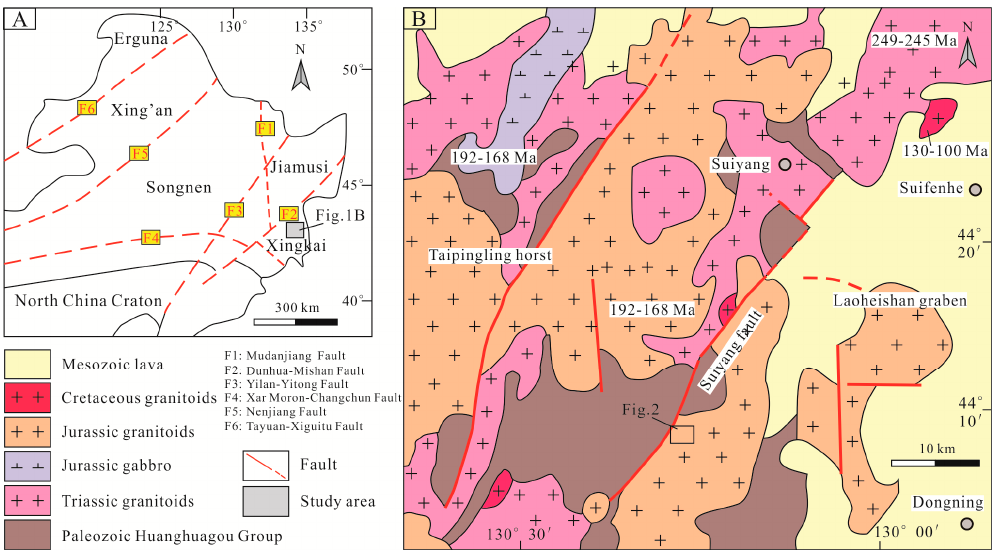
Figure 1. ( A ) Simplified tectonic map of northeast China [19]. ( B ) Regional geological sketch map (after Zhang et al. [19]. Ages of igneous rocks are annotated on the